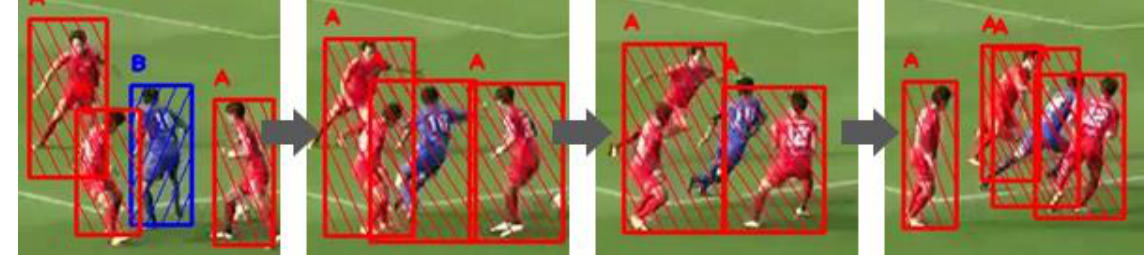
Figure 5. Examples of object recognition errors in a series of frame changes.